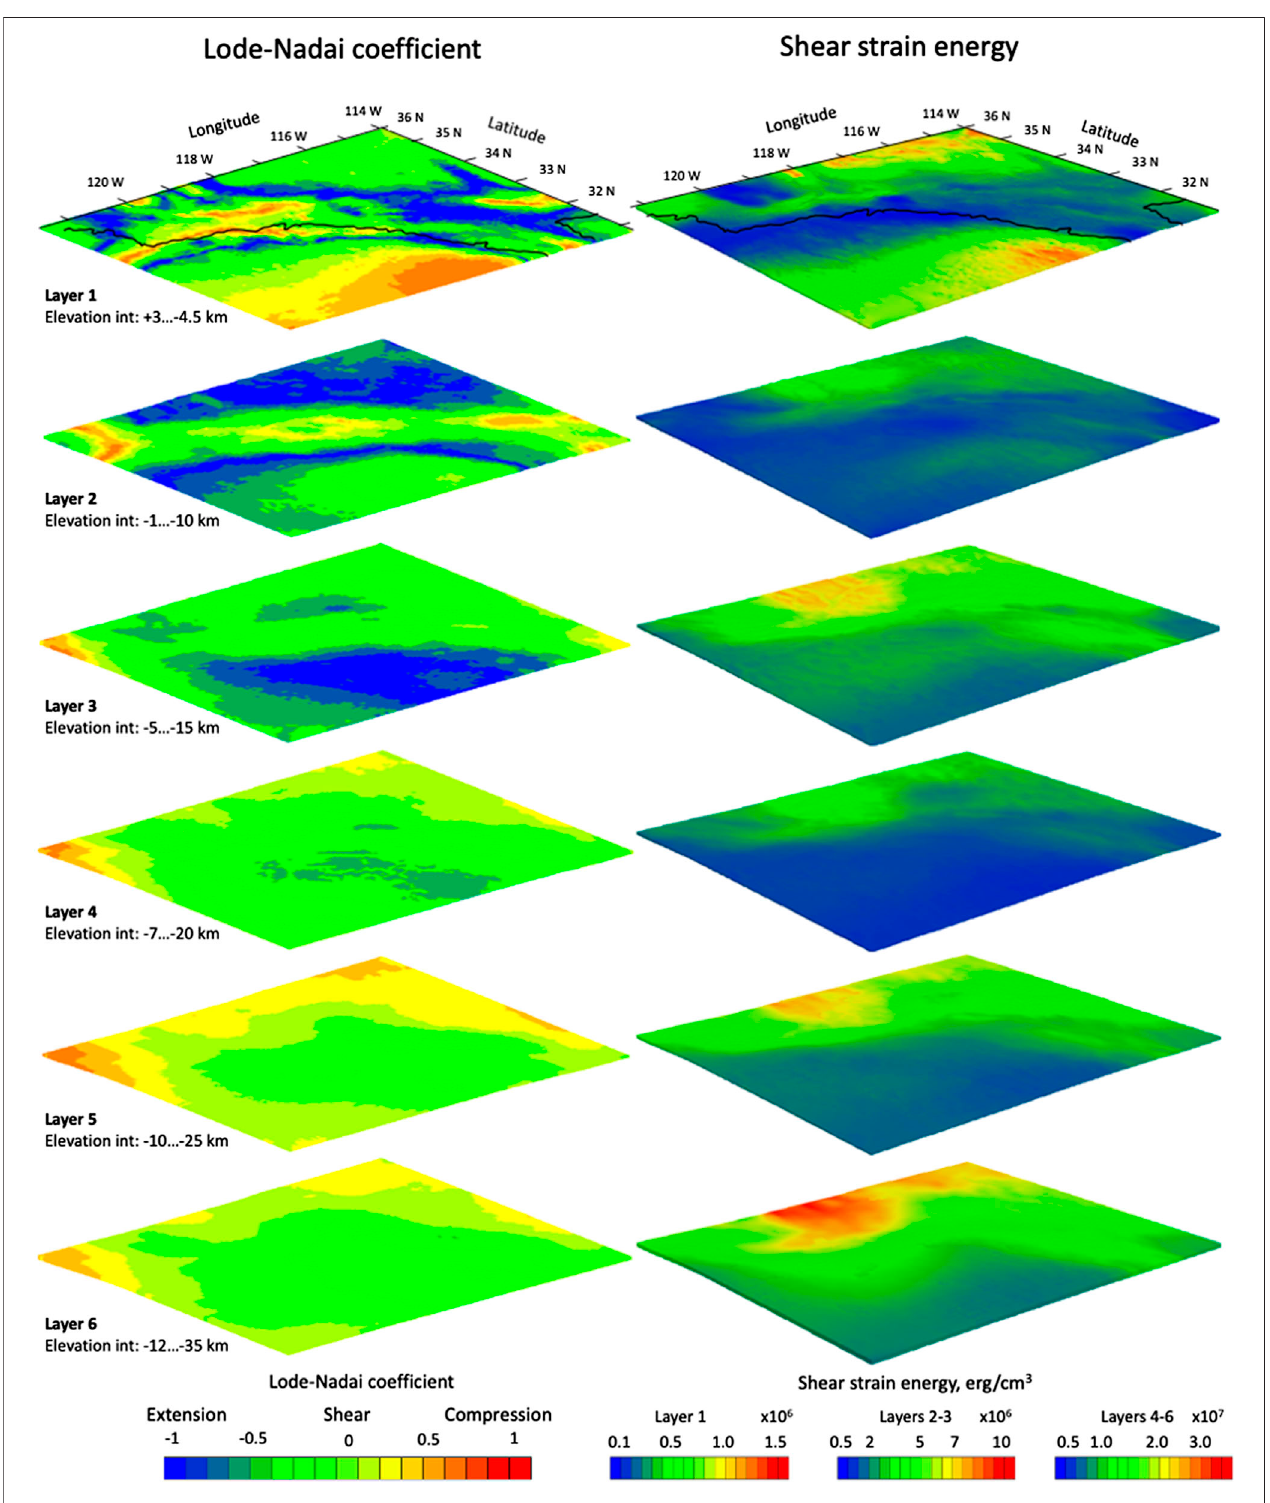
FIGURE 5 | Initial stress state maps for six crustal layers calculated assuming gravity load and horizontal tectonic stresses according to the No-Net-Rotation NUVEL-1 model (Argus and Gordon, 1991): Lode – Nadai coef fi cient (left column) and shear strain energy (right column) maps.